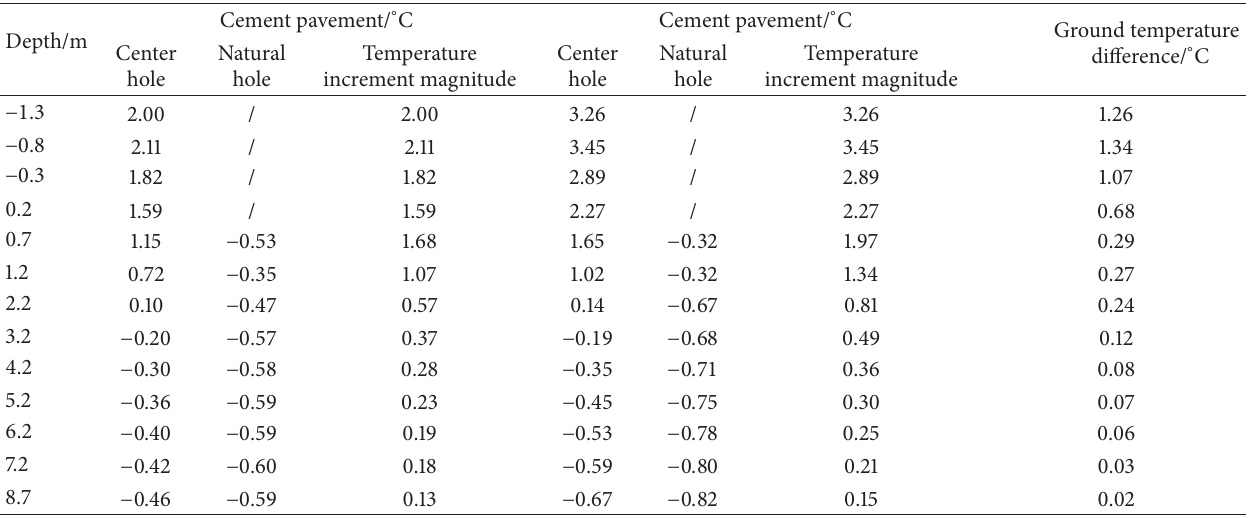
Table 3: The average temperatures of 03–06 years under asphalt pavement and cement pavement.